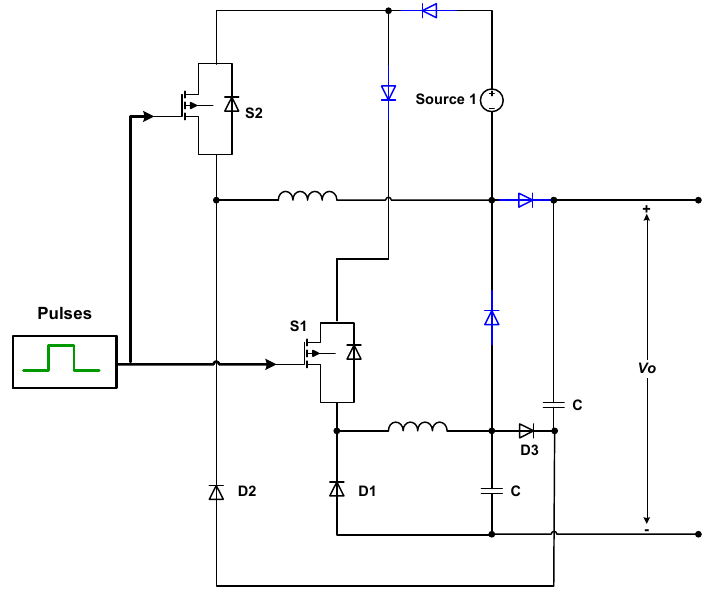
Figure 30. Modified DC–DC buck-boost converter to be supplied from only one source.